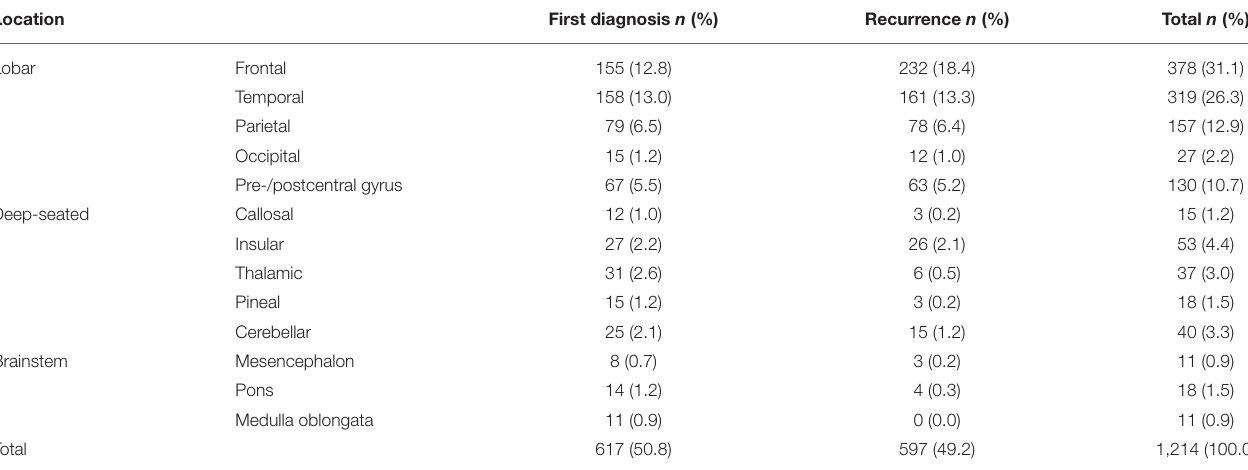
TABLE 1 | Biopsy location in primary and recurrent diseases.